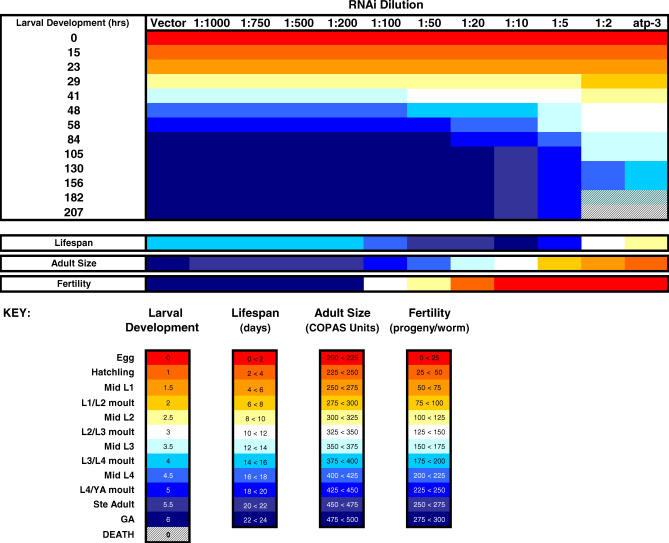
Concordance of the Mit PhenotypesFour phenotypes (top to bottom panels: mean larval developmental rate, mean lifespan, mean adult size, and mean fertility) were scored across an atp-3 RNAi dilution series. Data are derived from Figures 1 and 7 and Table S1 and is tabulated in a color-coded format (key). All four phenotypes become disrupted concordantly. At an RNAi dilution of 1:100 mean lifespan, mean adult size and mean fertility became recognizably different from vector-treated animals. By 1:50, mean larval development (assayed using a dissecting microscope and not high-power optics) became noticeably retarded. Larval development (top panel) was quantitated as follows: 30 freshly laid eggs were placed onto each of the indicated atp-3 RNAi dilutions (top row). At the listed times (left column), the stage of development of each hatchling was scored. An average developmental stage at each time interval was calculated by assigning each larval stage a number (shown in key) and then taking the average value for each 30-worm population.